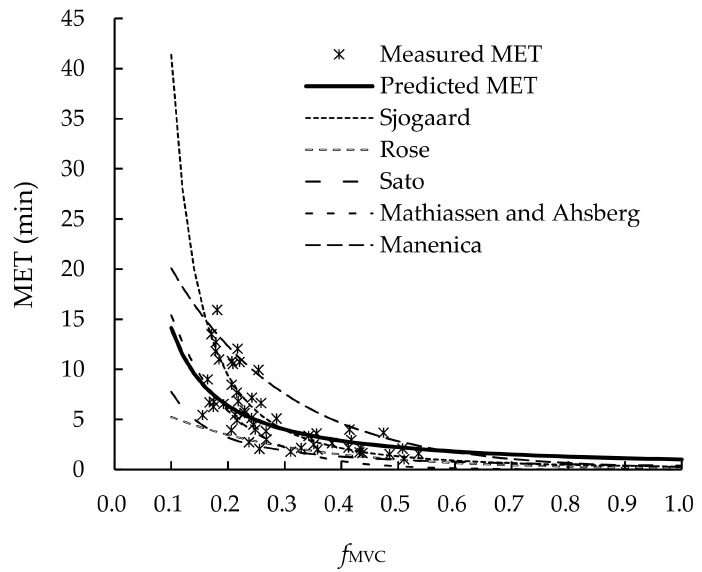
Figure 4. MET predictive models of muscle